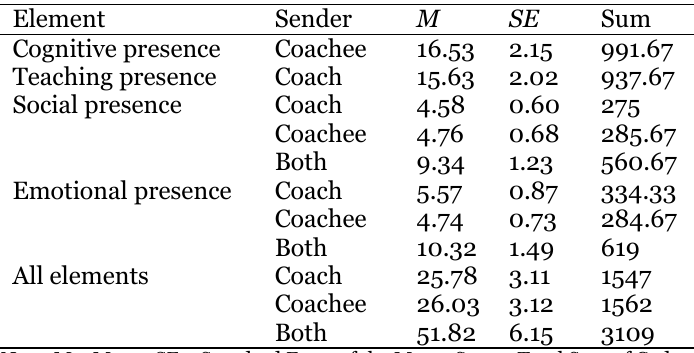
Descriptive statistics for the Elements